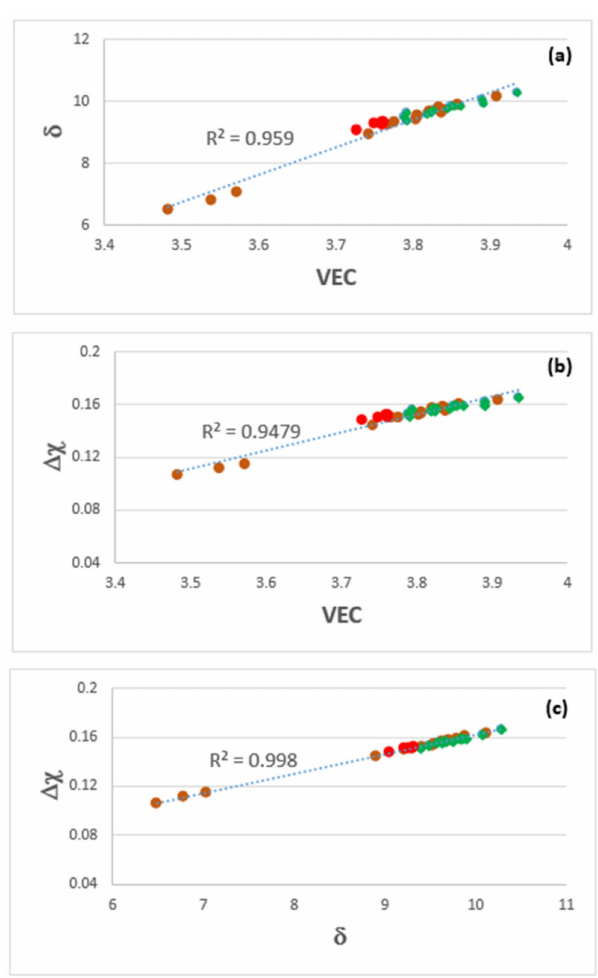
Figure 11. Plots of the parameters VEC, ∆ χ and δ for the alloys MG5 (green), MG6 (red) and MG7 (brown). ( a ) δ versus VEC, ( b ) ∆ χ versus VEC and ( c ) ∆ χ versus δ . The R 2 values correspond to all the data. For the R 2 values of the data only for the alloy MG7 see